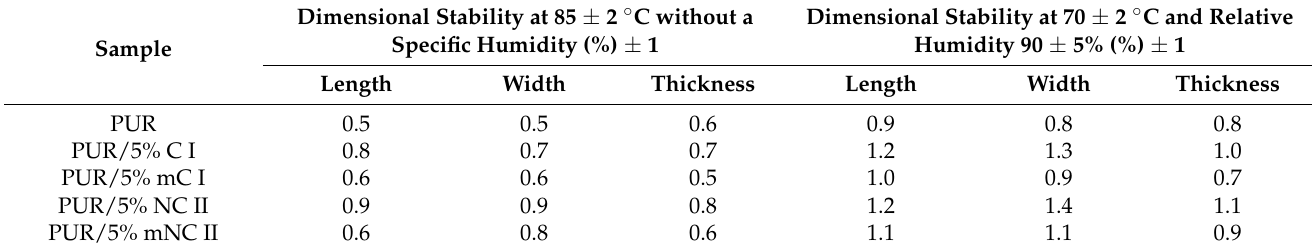
Table 4. Dimensional stability of composites depending on filler